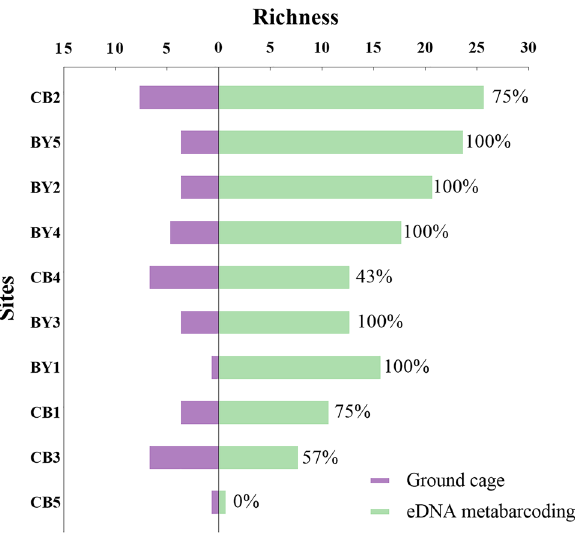
Figure 6. Species richness captured by both methods (the % is the proportion of the number of species obtained by both methods to species richness captured by ground cage